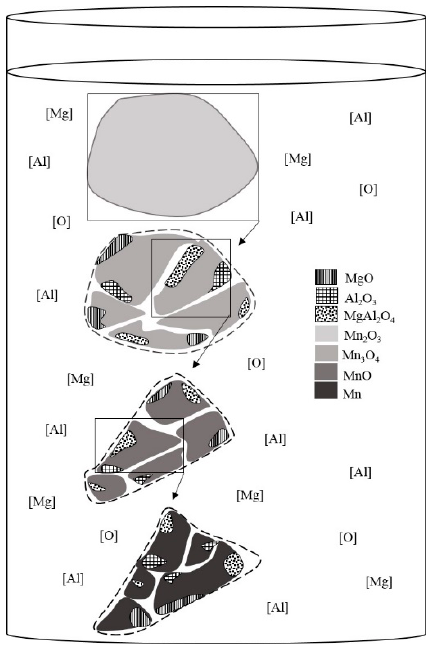
Figure 8. Schematic representation of the reaction mechanism.